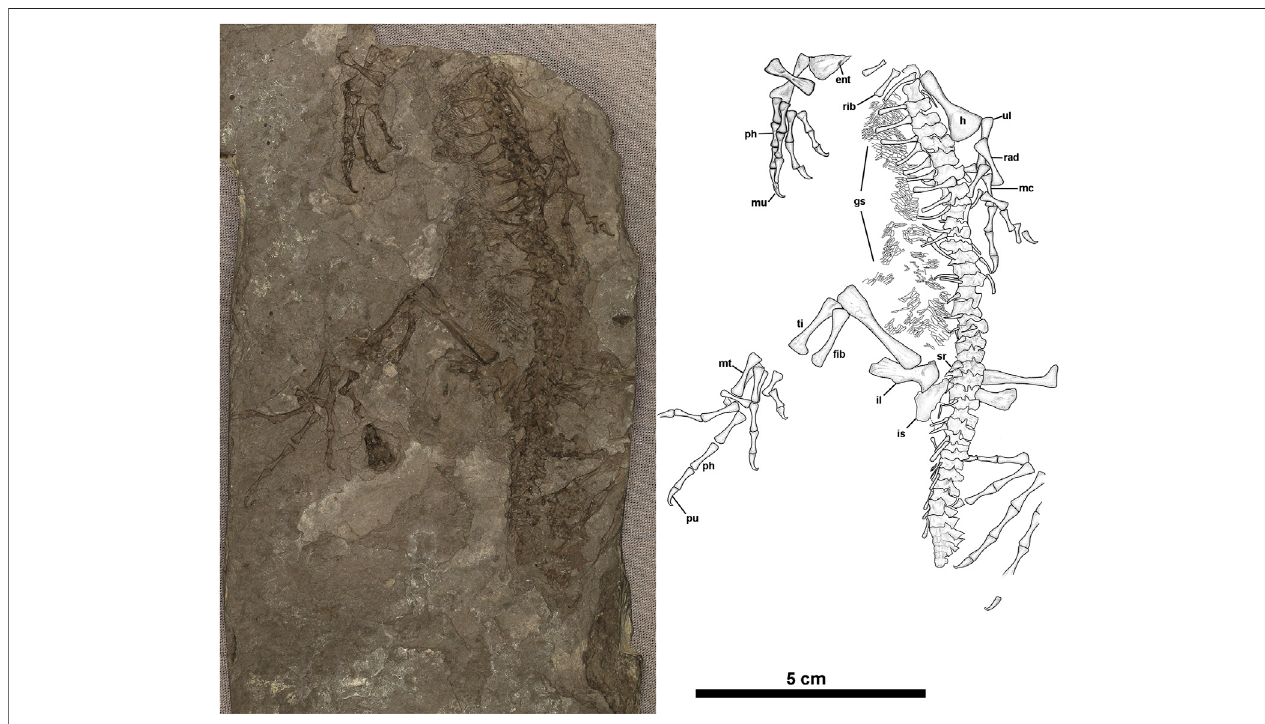
FIGURE 1 | Anthracodromeus longipes (CM 81532), (A) photograph and (B) illustration of CM 81532. Anatomical abbreviations: ent (cid:1) entepicondylar foramen, f (cid:1) femur, fi b (cid:1) fi bula, gs (cid:1) gastralia, h (cid:1) humerus, is (cid:1) ischium, il (cid:1) ilium, mc (cid:1) metacarpal, mt (cid:1) metatarsal, mu (cid:1) manual ungual, ph (cid:1) phalanx, pu (cid:1) pedal ungual, rad (cid:1) radius, sr (cid:1) sacral ribs, ti-tibia, ul (cid:1) ulna.